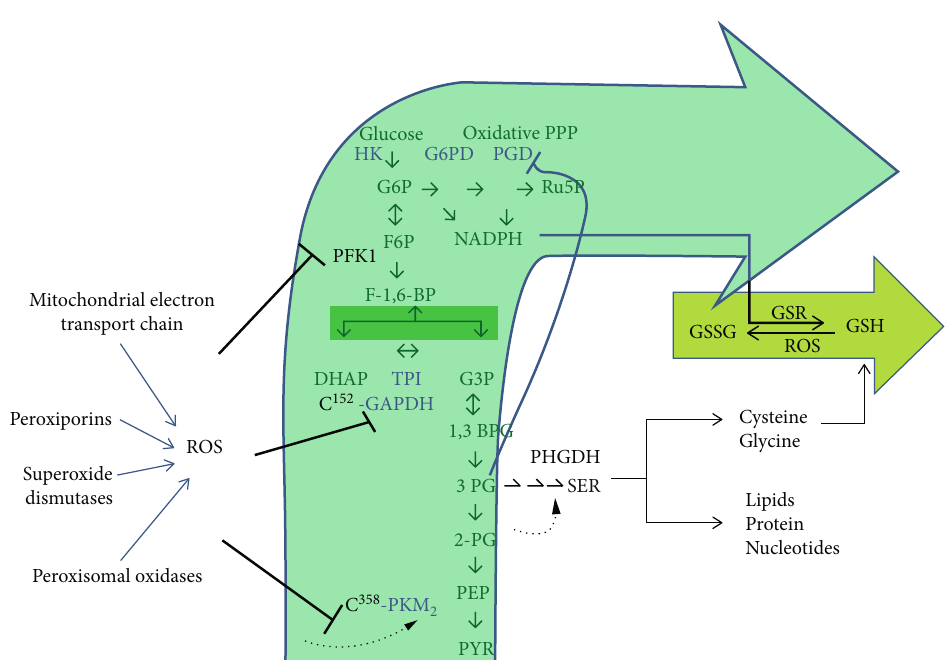
Figure 1: Reactive oxygen species- (ROS-) mediated inhibition of glycolysis reroutes fl ux into the oxidative arm of the pentose phosphate pathway. The enzymes inhibited by ROS are shown. ROS inhibits phosphofructokinase 1 (PFK1) and inactivates glyceraldehyde 3- phosphate dehydrogenase (GAPDH) and the pyruvate kinase isoform PKM2 by directly targeting cysteine residues. Thus, this glycolytic inhibition promotes fl ux into the oxidative pentose phosphate pathway (PPP) to produce NADPH and fuel cellular antioxidant systems (for example NADPH is consumed by glutathione reductase (GSR) to recycle oxidized glutathione (GSSG)). PKM2 inhibition is unique in that it allows for a diversion of fl ux into the serine synthesis pathway. Serine not only contributes to the synthesis of macromolecules but is also a precursor for glutathione (GSH). Serine synthesis is activated by a buildup of 2-phosphoglycerate (2PG), which prevents 3- phosphoglycerate- (3PG-) induced inhibition of the oxidative pentose phosphate arm. PPP: pentose phosphate pathway; HK: hexokinase; G6PD: glucose-6 phosphate dehydrogenase; PGD: phosphogluconate dehydrogenase; G6P: glucose-6-phosphate; Ru5P: ribulose-5- phosphate; F6P: fructose-6-phosphate; NADPH: nicotinamide adenine dinucleotide phosphate; PFK1: phosphofructokinase 1; F1,6 BP: fructose 1,6 bisphosphate; DHAP: dihydroxyacetone phosphate, TPI: tirose phosphate isomerase; G3P: glyceraldehyde-3-Phosphate; GAPDH: glyceraldehyde-3 phosphate dehydrogenase; 1,3 BPG: 1,3-bisphosphoglycerate; 3 PG: 3-phosphoglycerate; 2-PG: 2- phosphoglycerate; PEP: phosphoenolpyruvate; PYR: pyruvate; PKM2: pyruvate kinase isoform M2; PHGDH: 3-phosphoglycerate dehydrogenase; ROS: reactive oxygen species; GSSG: glutathione disul fi de (oxidized glutathione); GSR: glutathione reductase; GSH: glutathione (reduced glutathione); SER: